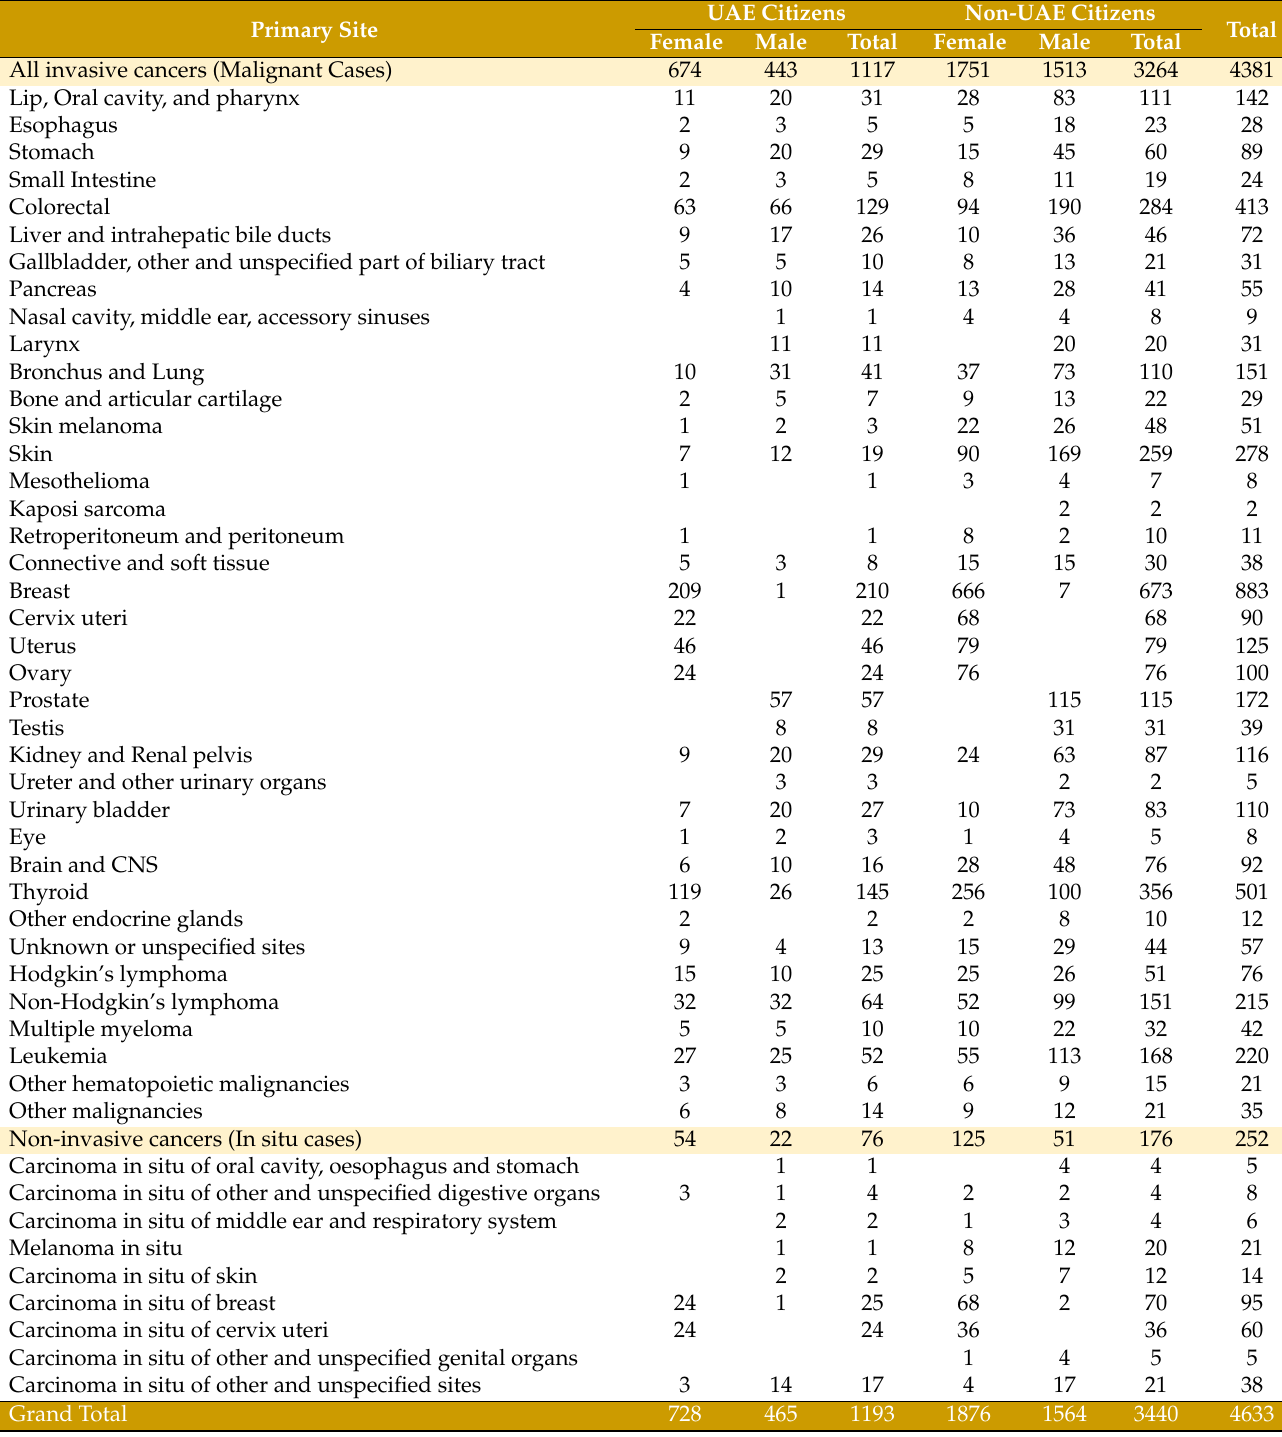
Table A1. Number of cancer cases among the UAE population according to primary site, gender,